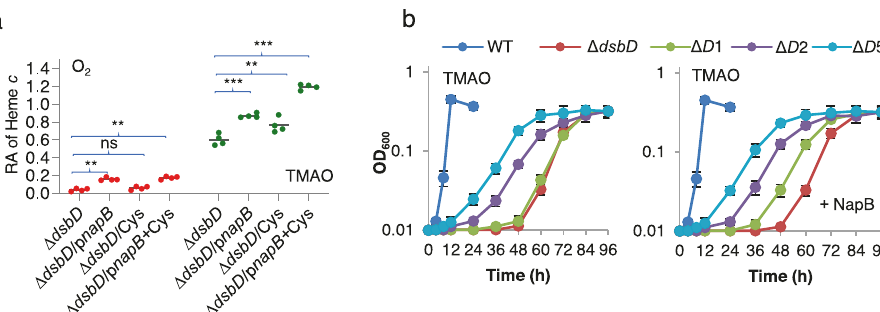
Fig. 7 Small reducing agents differ from NapB in modulating cyt c biosynthesis in the dsbD mutant. a Heme c levels in indicated strains grown to the early stationary phase. NapB expression was achieved in the presence of 1 mM IPTG. The relative abundance (RA) of heme c was obtained as described in Fig. 2b. Asterisks indicate statistically signi fi cant difference of the values compared ( n = 4; ns not signi fi cant, p > 0.05; * P < 0.05; ** P < 0.01; *** P < 0.001). b Growth of indicated strains on EAs speci fi ed. Δ D 1, Δ D 2, and Δ D 5, represent that Δ dsbD grew in the presence of 1, 2, 5 mM cysteine respectively. NapB expression was achieved in the presence of 0.2 mM IPTG. The experiments were performed four times, and the data were presented as the average ±